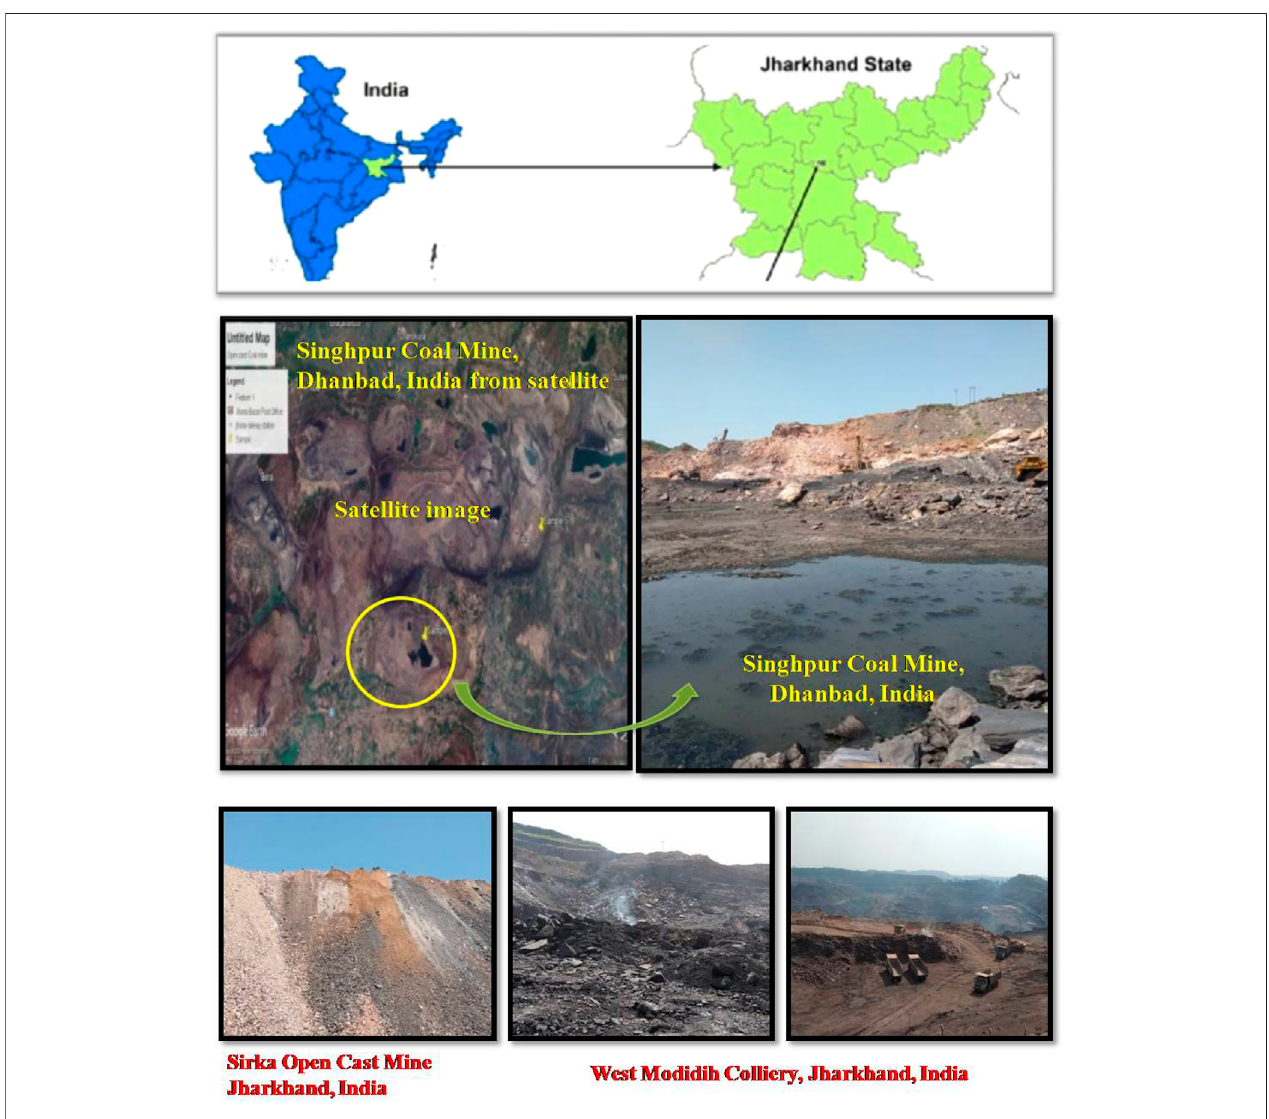
FIGURE 1 | Sites for collection of soil, coal, and sediment samples for isolation of sulfur-oxidizing bacteria.